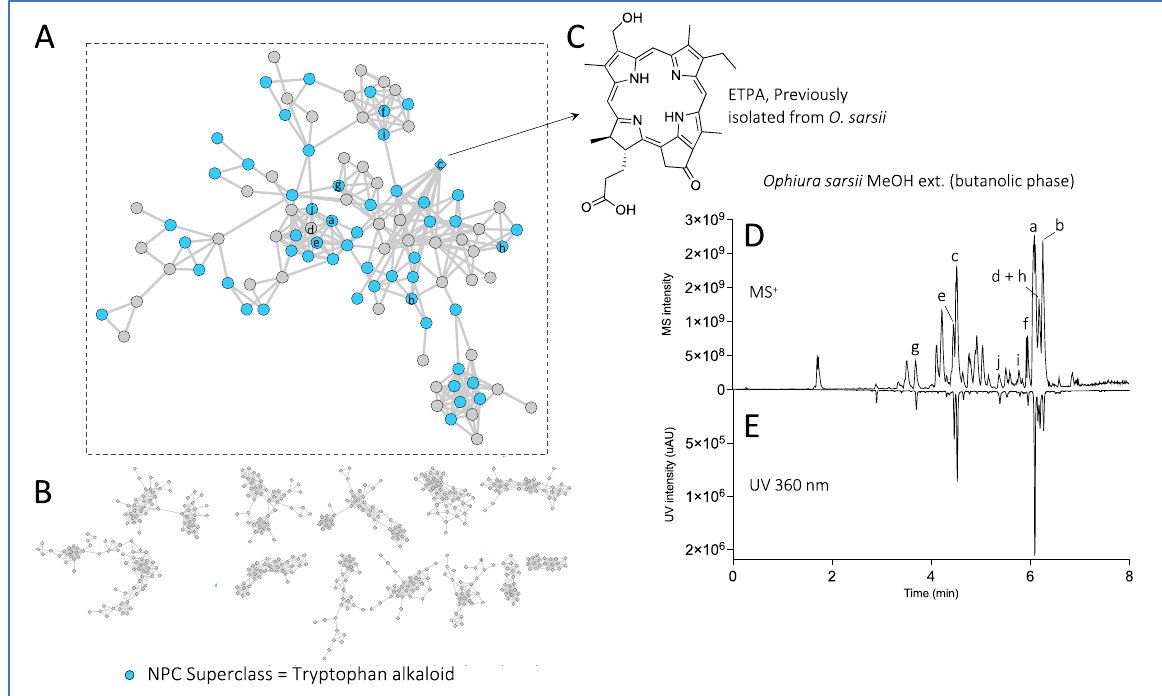
Figure 2. Feature-based Molecular Network of the EtOAc and MeOH (butanolic fraction) extracts of Ophiura sarsii . Nodes colored in blue belong to the “tryptophan alkaloid” predicted natural product superclass (NPClassifier). The previously isolated ETPA is displayed as a diamond. ( A ) The cluster containing chlorin ETPA and several related compounds. ( B ) Other major clusters of the Feature-Based Molecular Network. ( C ) Structure of the previously isolated ETPA. ( D ) UHPLC-MS profile of the MeOH extract (butanolic fraction) of O. sarsii with the 10 most intense ions of the chlorin cluster indicated with letters. ( E ) UHPLC-UV profile at 360 nm of the same extract. The same network mapped with the predicted natural product pathways is displayed in Supplementary Figure S33.